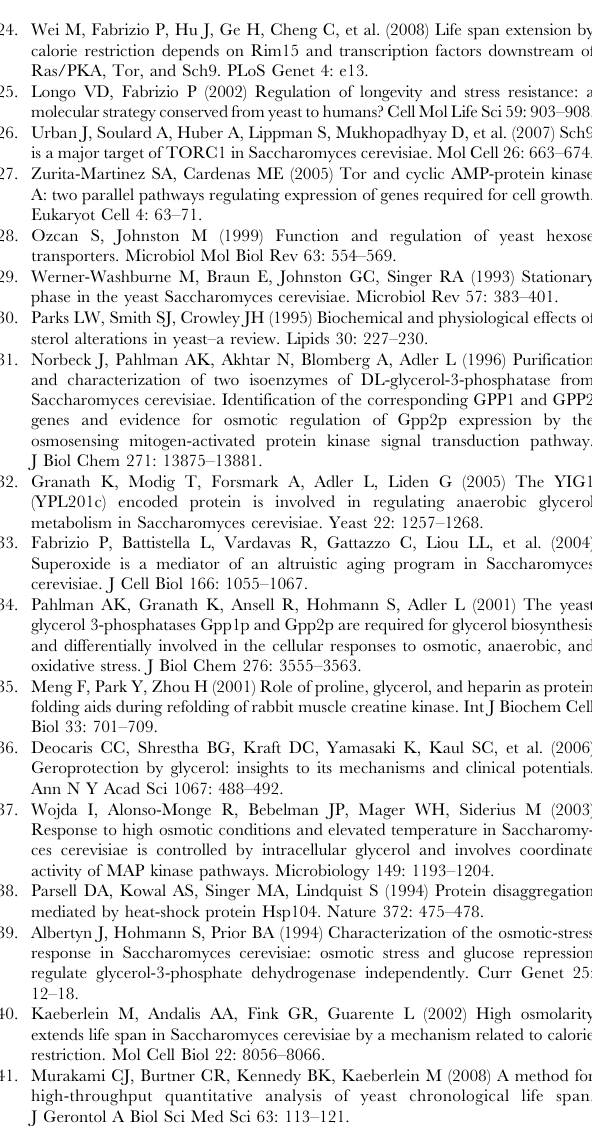
Table S6 Expression levels of genes involved in glycerol metabolism in long-lived sch9 D , tor1 D , and ras2 D mutants at day 2.5. The glycerol biosynthesis gene subset contains 21 genes. Denote the gene subset by S and the entire gene as a whole by G. We compared expressions of S against those in the complement of S in G denoted by G-S. The Wilcoxon rank test (one-sided) was performed. We found that glycerol biosynthesis gene set is up- regulated with p -value 0.0058 in sch9 D , 0.0614 in tor1 D , and 0.0142 in ras2 D . For illustration purpose, gene expression levels that are 20% higher or lower than wild type cells are marked in red or green, respectively. 1 Data were expressed in fold change, WT = 1. 2 Array probe specificity. 3 Day 1.5-old SDC wild type (DBY746) cells were washed 3 times with water and incubated in water for 24 or 48 hours. Data represent fold change compared to wild type cells in SDC.